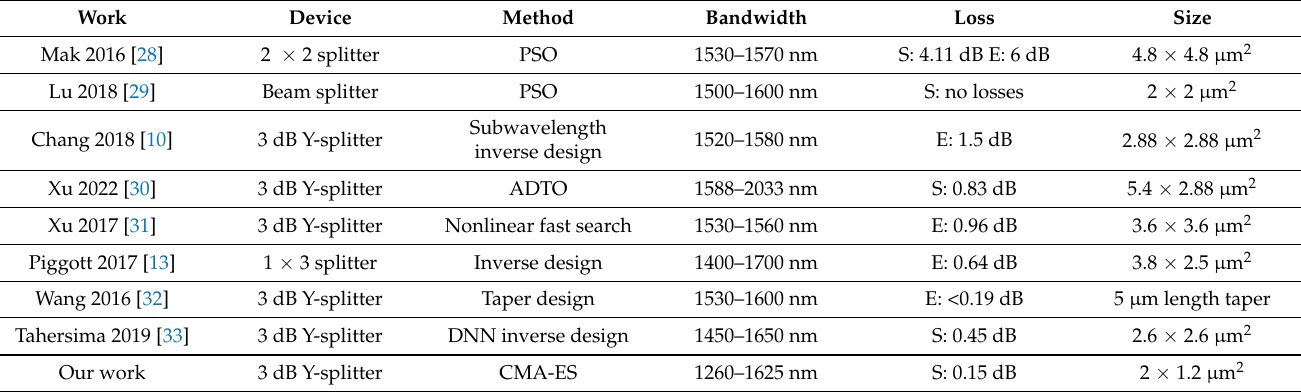
Table 1. Comparison of photonic devices designed using iterative optimization